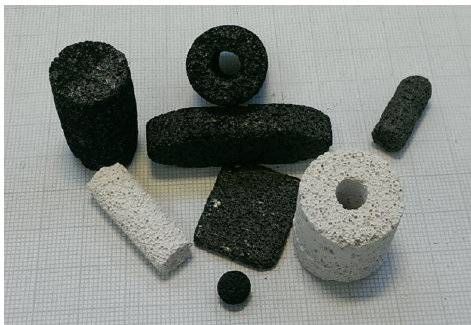
Figure 1. Carbon replicas and selected porous concrete-made template monoliths (one square of the pad corresponds to 10 mm).